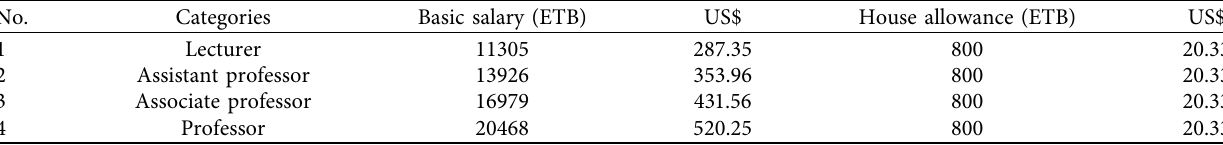
Table 1: Ethiopian higher education academic staff salary and housing